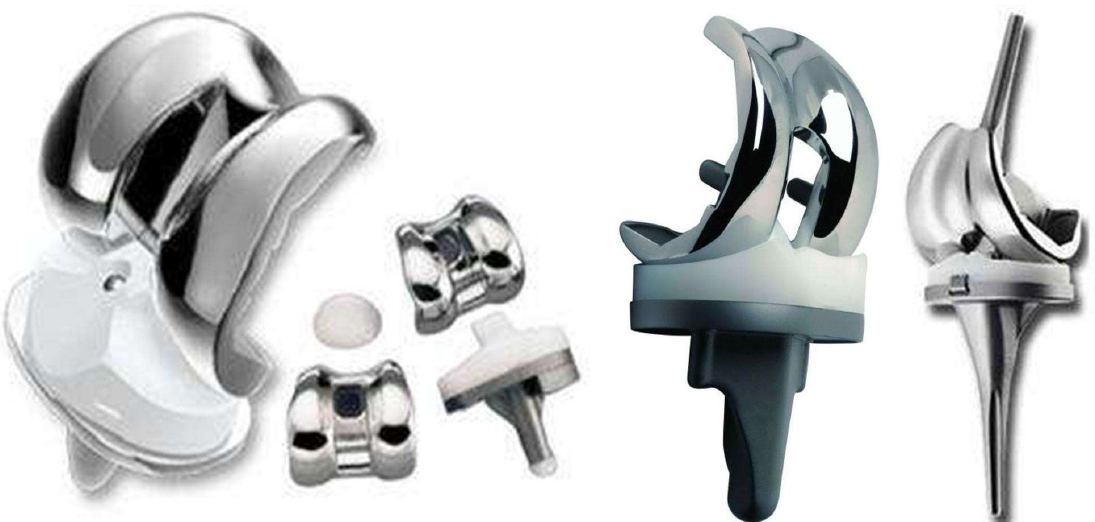
Figure 1. Titanium alloy artificial joints with complex geometric surfaces